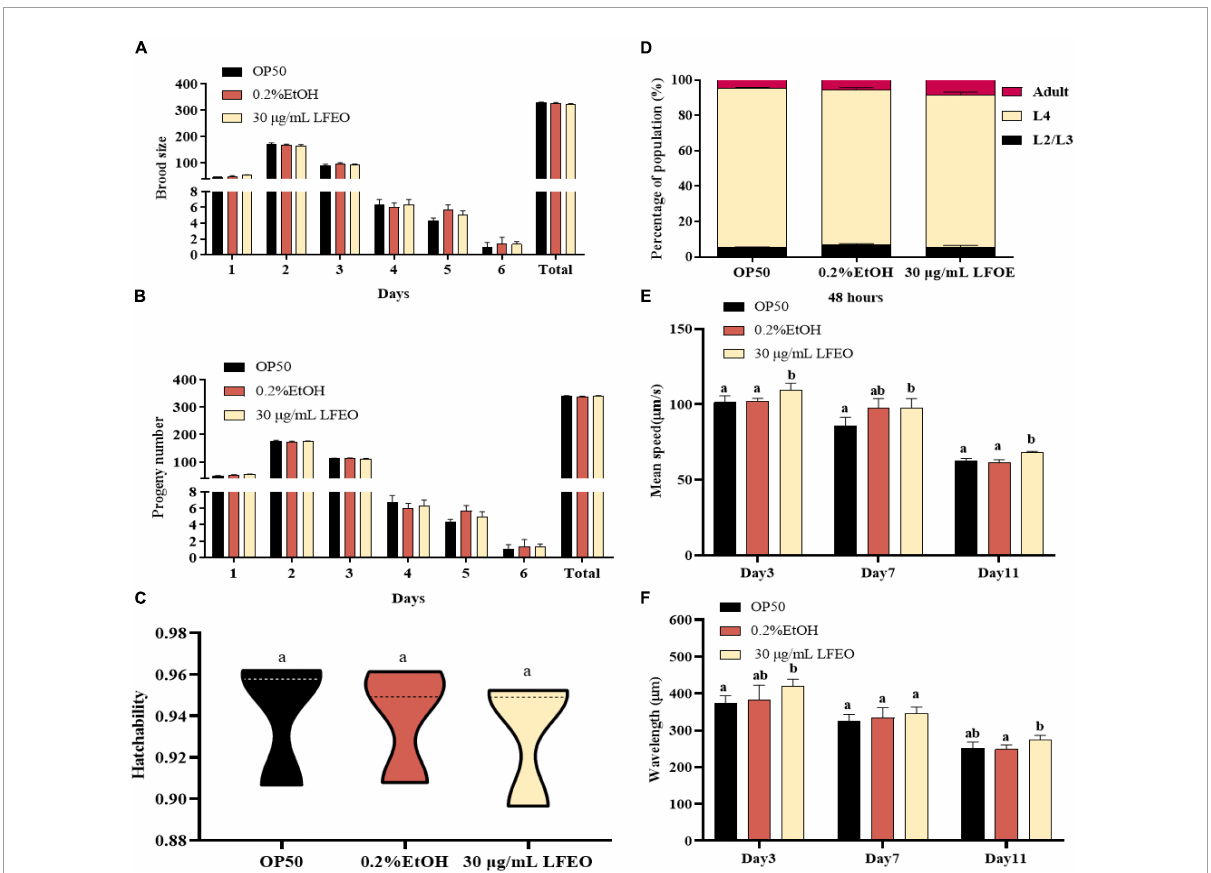
FIGURE6 The effect of litchi flower essential oil (LFEO) on energy metabolism of worms. (A) Distributions of daily egg production and total egg production of adult nematodes. (B) The hatching of laid eggs every day. (C) Comparison of hatchability toward nematodes in different groups. (D) Determination of LFEO influence on nematode growth rate. Using the WormLab equipment determined the average speed (E) and wavelength (F) of nematodes that were treated with LFEO for 3, 7, and 11 days, respectively. Statistical analysis of the results was done using a one-way ANOVA with Bonferroni tests as post hoc comparison; different letters indicate a significant difference, p < 0.05, with at least 10 worms per